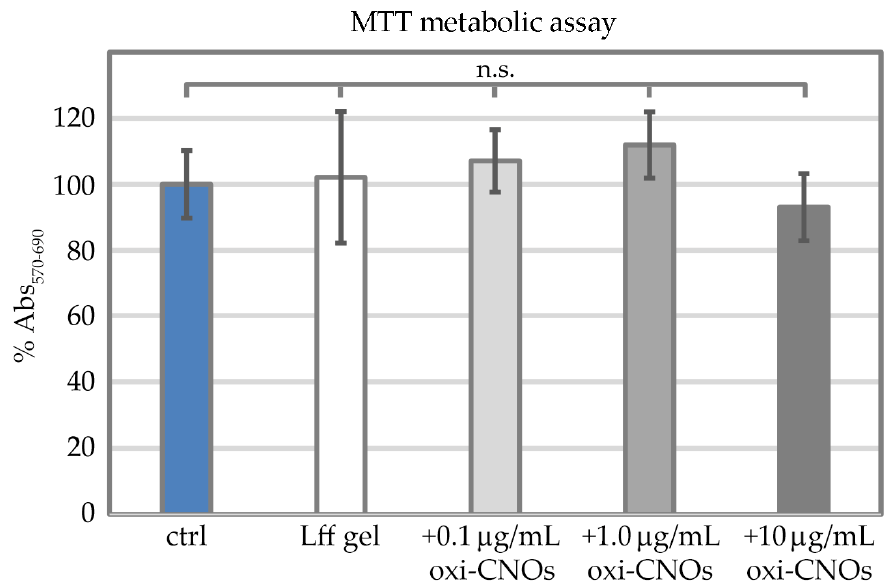
Figure 12. MTT metabolic assay on fibroblast cells grown on the plastic control (ctrl), the peptide gel without (Lff gel) or with increasing concentrations of oxi-CNOs (+0.1, +1.0, or +10 µ g/mL oxi-CNOs). No statistically significant (n.s.) difference was found between tested conditions ( p >0.05).